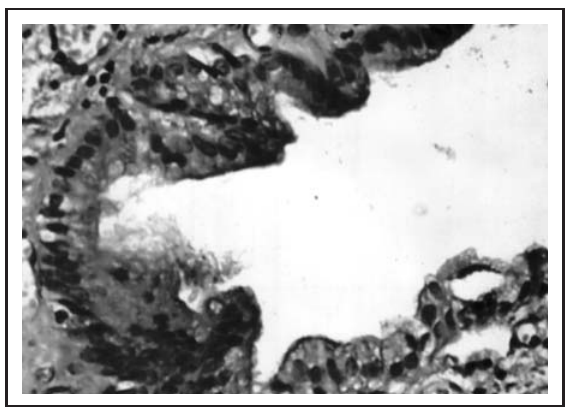
Figure 6. Metaplasia in chronic cholecystitis showing Sialomucin positivity (Mild PAS-Stain x 200). Among all the cross tabulations between neutral, sulfated and sailo mucins with gastric metaplasia in this study, the sulfated mucin with gastric metaplasia (cid:17)(cid:12)(cid:8)(cid:26)(cid:19)(cid:27)(cid:10)(cid:5)(cid:10)$(cid:19)(cid:14)(cid:20)(cid:10)(cid:12)(cid:2)(cid:13)(cid:12)(cid:10)(cid:17)(cid:2)(cid:13)(cid:3)(cid:2)(cid:23)(cid:18)(cid:5)(cid:3)(cid:7)(cid:10)@’$(cid:5)(cid:16)(cid:15)(cid:19)(cid:10)(cid:8)(cid:22)(cid:10)(cid:10)&(cid:28)&&Q(cid:28)(cid:10)(cid:29)(cid:12)(cid:2)(cid:17)(cid:10) (cid:26)(cid:5)(cid:17)(cid:10)(cid:22)(cid:8)(cid:16)(cid:16)(cid:8)(cid:26)(cid:19)(cid:27)(cid:10)(cid:24)(cid:20)(cid:10)(cid:3)(cid:19)(cid:15)(cid:7)(cid:14)(cid:5)(cid:16)(cid:10)(cid:6)(cid:15)(cid:18)(cid:2)(cid:3)(cid:10)(cid:26)(cid:2)(cid:7)(cid:12)(cid:10)(cid:17)(cid:2)(cid:13)(cid:3)(cid:2)(cid:23)(cid:18)(cid:5)(cid:3)(cid:7)(cid:10)(cid:21)’$(cid:5)(cid:16)(cid:15)(cid:19)(cid:10) (cid:8)(cid:22)(cid:10)(cid:10)&(cid:28)&(cid:30)(cid:10)(cid:5)(cid:3)(cid:27)(cid:10)(cid:8)(cid:22)(cid:10)(cid:17)(cid:5)(cid:2)(cid:16)(cid:8)(cid:6)(cid:15)(cid:18)(cid:2)(cid:3)(cid:10)(cid:26)(cid:2)(cid:7)(cid:12)(cid:10)(cid:3)(cid:8)(cid:3)(cid:10)(cid:17)(cid:2)(cid:13)(cid:3)(cid:2)(cid:23)(cid:18)(cid:5)(cid:3)(cid:7)(cid:10)(cid:21)’$(cid:5)(cid:16)(cid:15)(cid:19)(cid:10) of 0.666 (Table 3). Among all the cross tabulations between neutral, sulfated and sailo mucins with intestinal metaplasia in this study revealed positivity in 34.0%, 21.0% and 1.0% cases respectively. The sulfated mucin with intestinal (cid:6)(cid:19)(cid:7)(cid:5)(cid:21)(cid:16)(cid:5)(cid:17)(cid:2)(cid:5)(cid:10) (cid:17)(cid:12)(cid:8)(cid:26)(cid:19)(cid:27)(cid:10) (cid:5)(cid:10) $(cid:19)(cid:14)(cid:20)(cid:10) (cid:12)(cid:2)(cid:13)(cid:12)(cid:10) (cid:17)(cid:2)(cid:13)(cid:3)(cid:2)(cid:23)(cid:18)(cid:5)(cid:3)(cid:7)(cid:10) (cid:21)’$(cid:5)(cid:16)(cid:15)(cid:19)(cid:10) (cid:8)(cid:22)(cid:10) 0.006. This was followed by neutral mucin with p-value of 0.19 and of sailomucin with p-value of 0.840. The different categories, its positivity and negativity, p-value and remarks (Table 4).